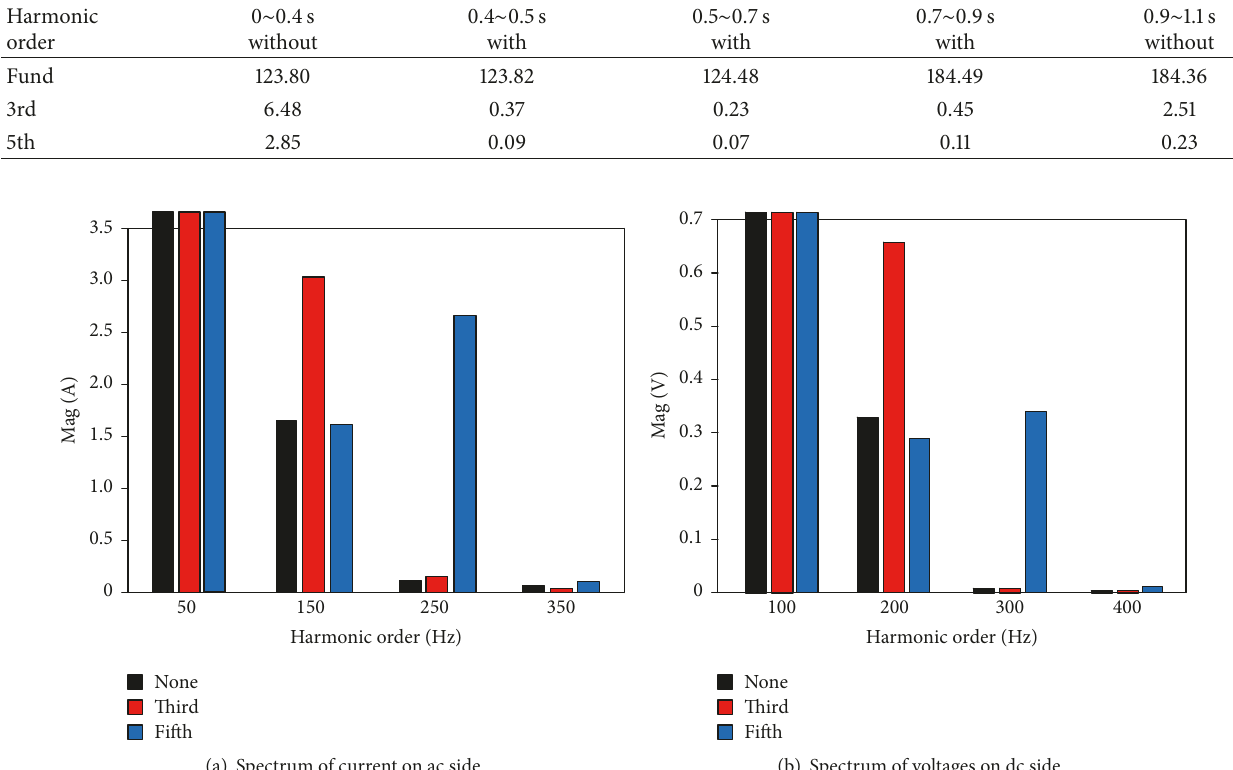
Figure 5: The grid voltage contains third and fifth harmonic.